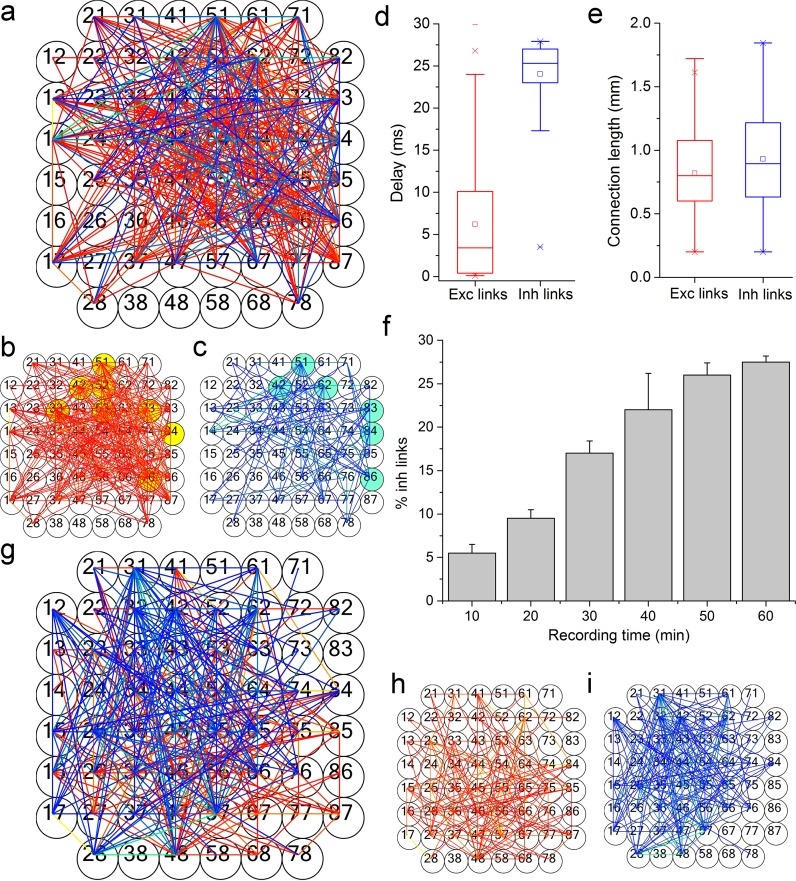
Functional connectivity analysis on different neural network populations coupled to the MEA-60 device.a, Functional connectivity graph obtained by applying the FNCCH to a cortical network at DIV 25. Excitatory and inhibitory links are separately thresholded and shown, for reader convenience, in panel b, (excitation, red color map) and c, (inhibition, blue color map). Color scales are indicative of the relative connection strength based on the peak of FNCCH. Yellow circles in panel b and cyan circles in panel c represent the identified rich club nodes. d, Box plot of the delays of the detected functional links. e, Box plot of the connection lengths of the detected links. f, Mean percentage of the inhibitory links revealed by the FNCCH at varying the recording time. g, Example of functional connectivity graph relative to a striatal network at DIV 21 coupled to a MEA-60 device. Panels h, and i, show the excitatory (red color map) and inhibitory (blue color map) networks, respectively.